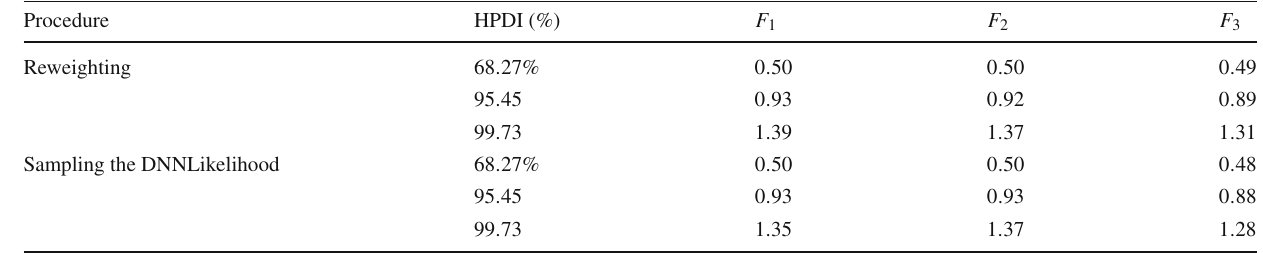
in the hypothesis μ > 0 and should be compared with the last column of Table